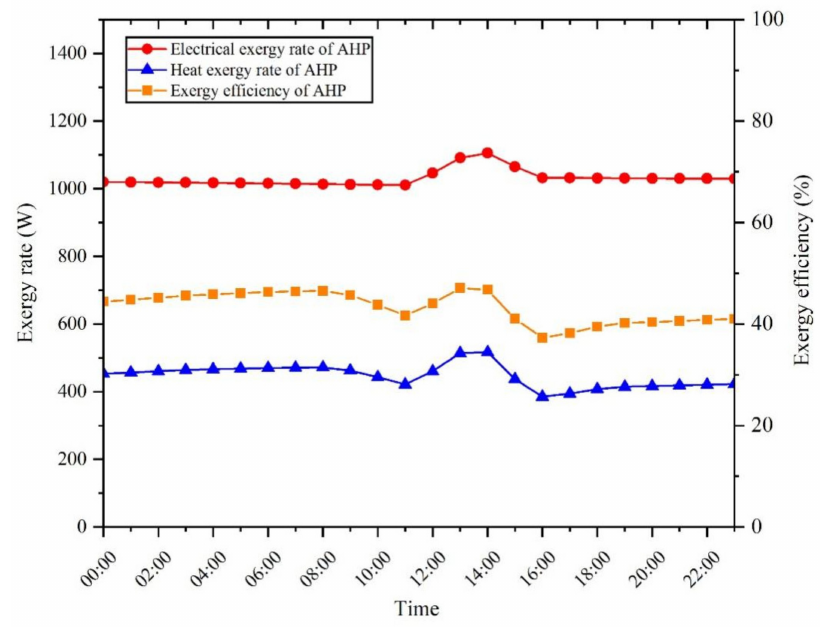
Figure 8. Exergy performance of AHP on 15 January.